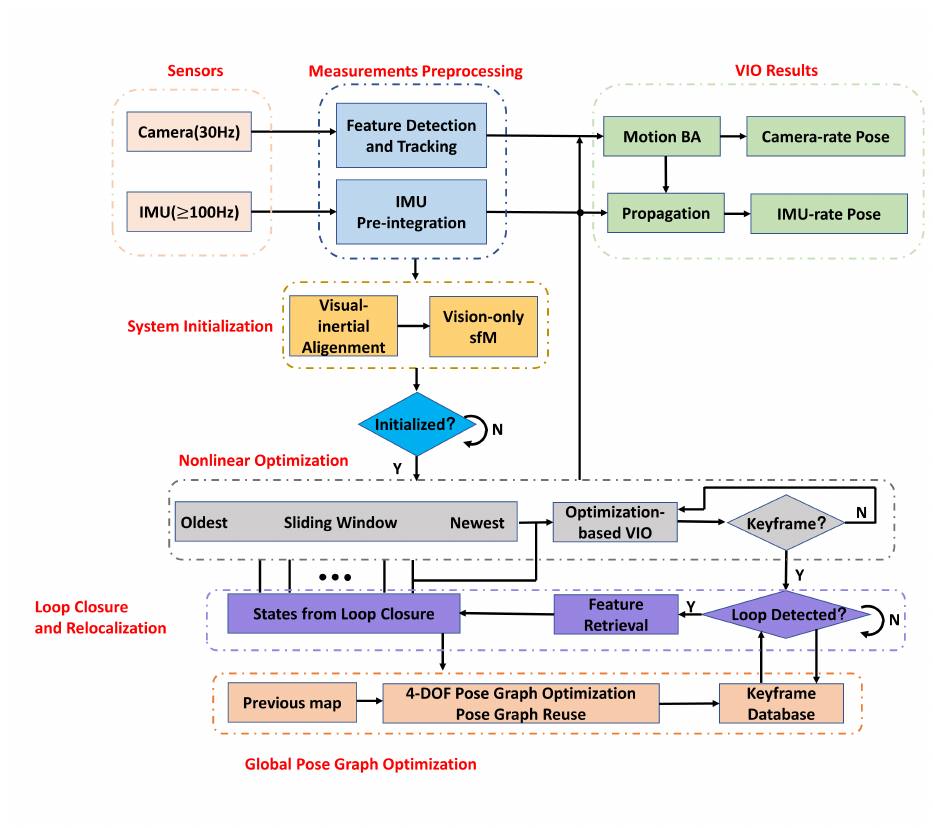
Figure 3. The framework of